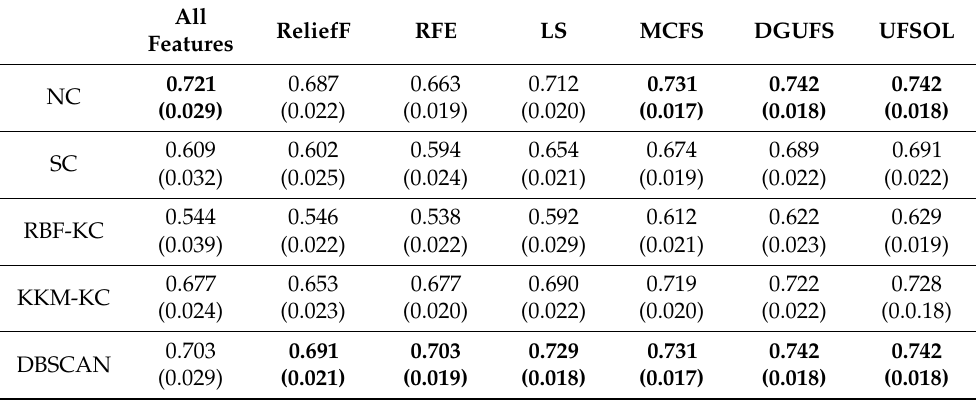
Table 4. Accuracy of clustering algorithms with different feature selection